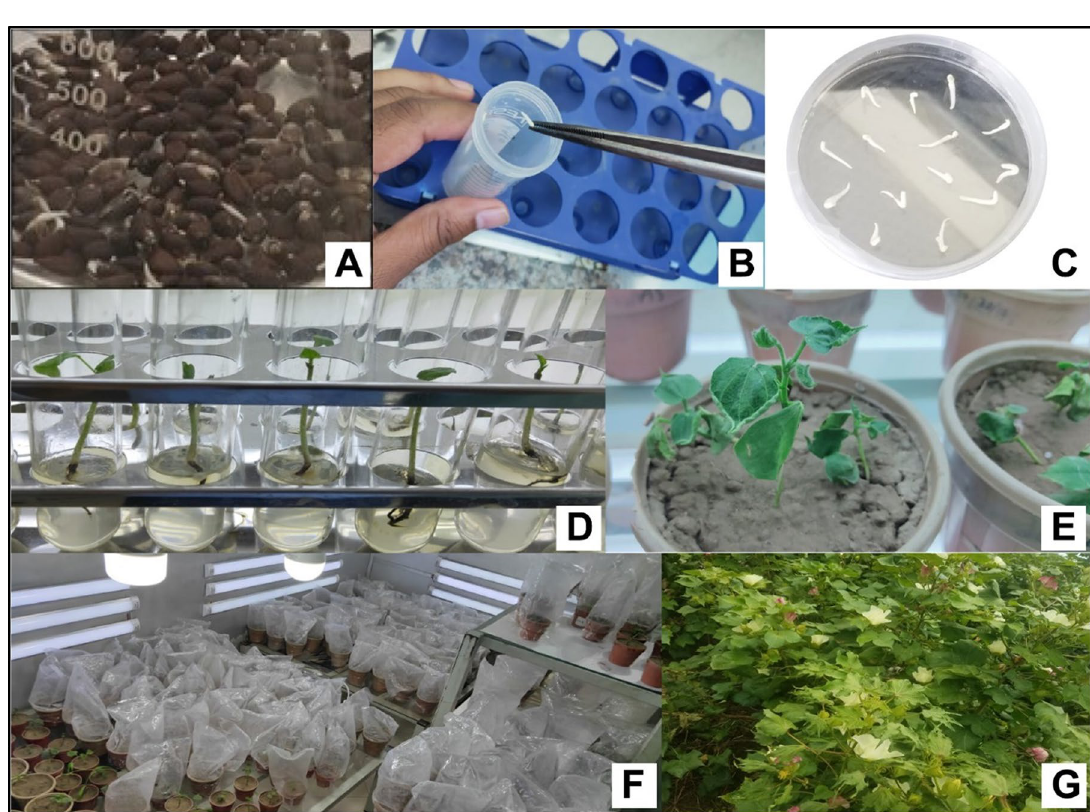
Figure 4. A schematic procedure of gene transformation in cotton; ( A ) soaking of seeds, ( B ) co-cultivation of embryos into MS media, ( C ) shifting of embryos on MS plates, ( D ) shifting of embryos into MS tubes, ( E,F ) shifting of plants into the pots, ( G ) shifting of plants into the field.